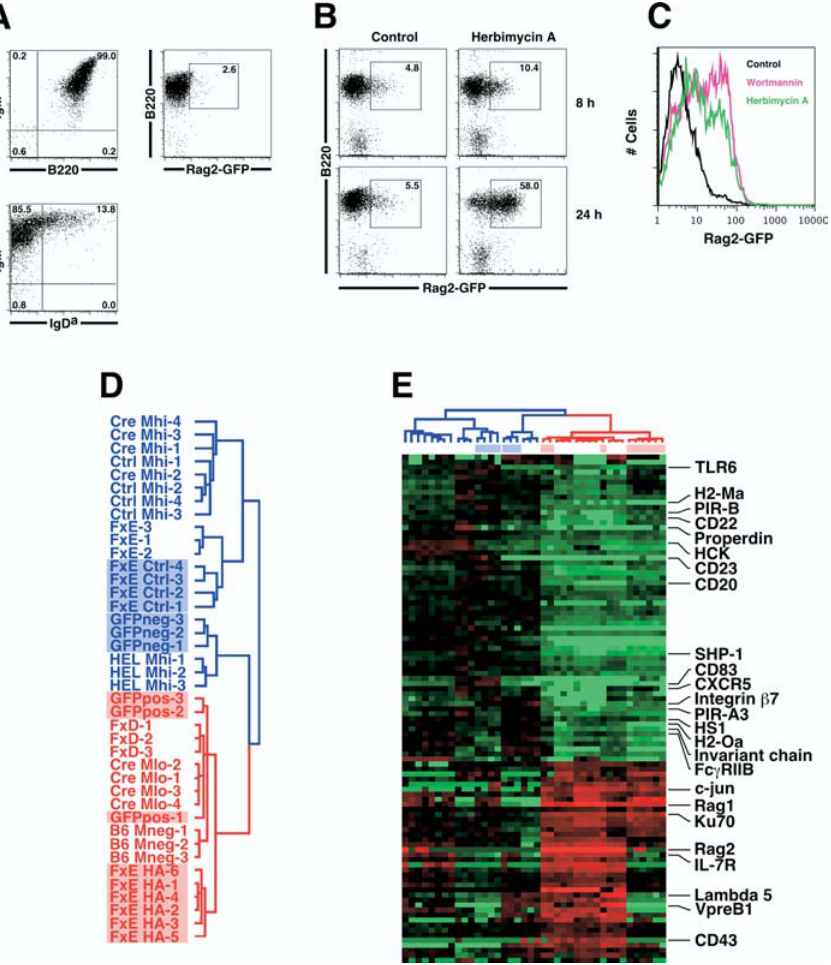
Figure 6. Immature B Cells Undergo a Reversal in Development after Blockade of Basal Ig Signaling with Herbimycin A or Wortmannin (A) Flow cytometric profile of HEL-Ig/Rag2-GFP BM at the end of a 5-d IL-7 culture. Cells are electronically gated by forward and side light scatter, and represent all lymphoid cells in the culture. The majority of cells were Rag-GFP (cid:1) IgM þ IgD (cid:1) immature B cells. (B) After a 5-d IL-7 culture, HEL-Ig/Rag2-GFP cells were washed and incubated with medium alone (containing DMSO carrier) or with 300 ng/ml herbimycin A for 8 or 24 h. Cells were then analyzed by flow cytometry, with cells gated based on size and annexin-V exclusion. Numbers represent percent of gated cells. (C) A representative experiment of Rag2-GFP expression levels in HEL-Ig/Rag2-GFP immature B cells incubated for 24 h with medium alone (black), herbimycin A (300 ng/ml) (green), or wortmannin (30 mM) (pink). (D and E) HEL-Ig/Rag2-GFP BM was cultured in IL-7 for 5 d, and cells were then incubated with herbimycin A (400 ng/ml) for 1 d. IgM þ GFP þ [GFPpos (D)] cells were sorted from herbimycin A treated populations, and IgM þ GFP (cid:1) [GFPneg (D)] cells were sorted from control cultures. In parallel, immature B cells were sorted from the BM of bcl-2 transgenic mice, and cultured with medium alone for 24 h (FxE Ctrl 1 and -2) or 48 h (FxE Ctrl 3 and 4), or with herbimycin A for 24 h (FxE HA-1, -2, -3, and -4) or 48 h (FxE HA-5 and -6). Total RNA was isolated from the cell populations and biotinylated cRNA probes were generated and hybridized to Affymetrix chips (E). All other cell populations were as described in Figure 2. The array data were clustered using the 101 transcripts from the Ctrl-M hi /Cre-M lo gene list that were also differentially expressed between normal FxD (pre-B) and FxE (immature B) cells (using the following criteria: 2-fold or greater change in mean expression level, a greater than 200-unit difference in mean expression values, and Student’s t-test p , 0.05). HC and LC transcripts were not used for this clustering analysis. The herbimycin A-treated immature B cells, both cultured and from bcl-2 Tg BM, cluster with more primitive cell populations. Data represent log 2 fold-differences, with individual expression values for each gene divided by the mean expression value of the Ctrl-M hi , HEL-M hi , FxE, GFP (cid:1) , and FxE Ctrl populations. Representative genes are